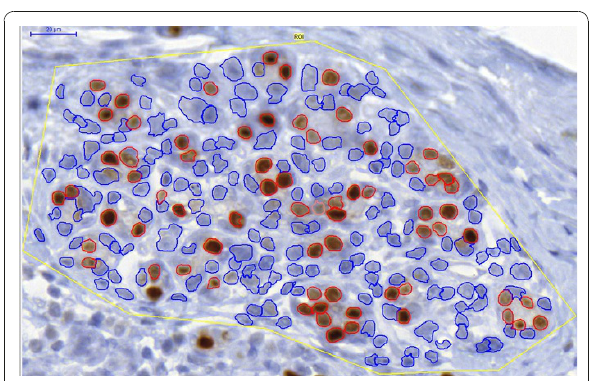
Figure 3 Object detection of the calibrated NuclearQuant algorithm . Blue = negative cells, Red = positive